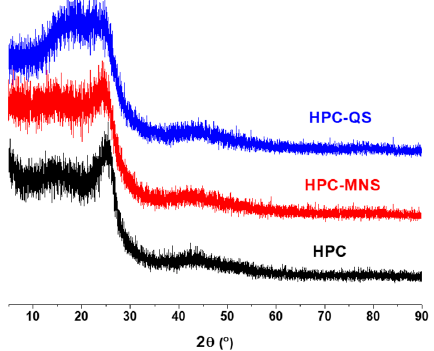
Figure 3. TGA curves of HPC, HPC-MNS and HPC-QS with a 100 mL/min nitrogen flow rate.